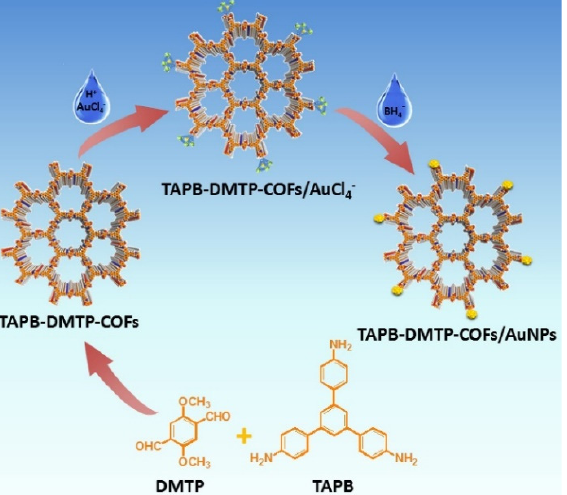
Figure 9. Illustration of synthesis route for TAPB-DMTP-COFs/AuNPs. Reprinted with permission from [103]. Copyright 2018, Elsevier.